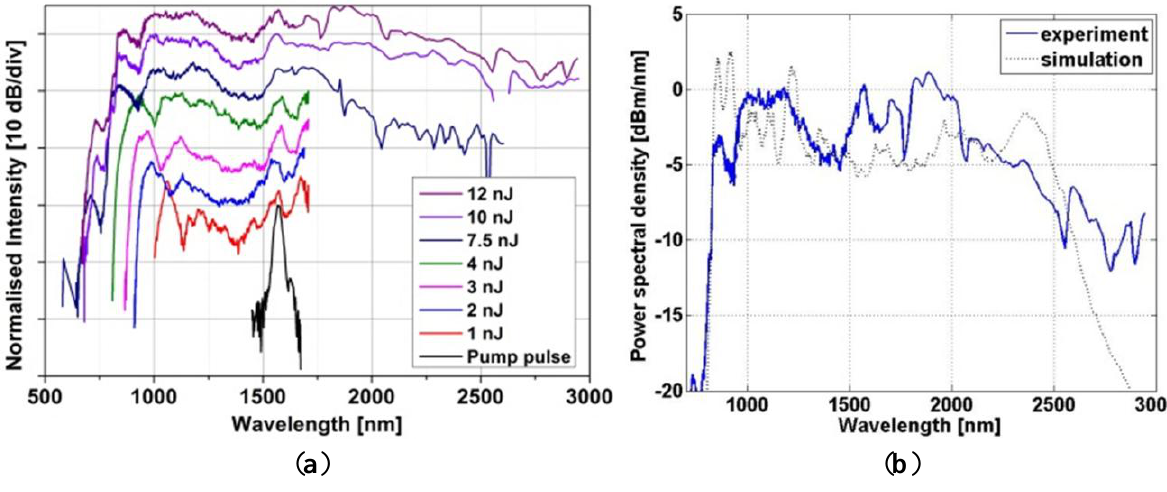
Figure 8. ( a ) Measured supercontinuum spectra in a 2 cm long PCF (pump: 150 fs, 1540 nm). Spectra are shown in the order from bottom to top, beginning with the pump pulse; ( b ) measured spectrum (solid trace) and numerical result (dotted trace) for 3.8 nJ pump pulse energy